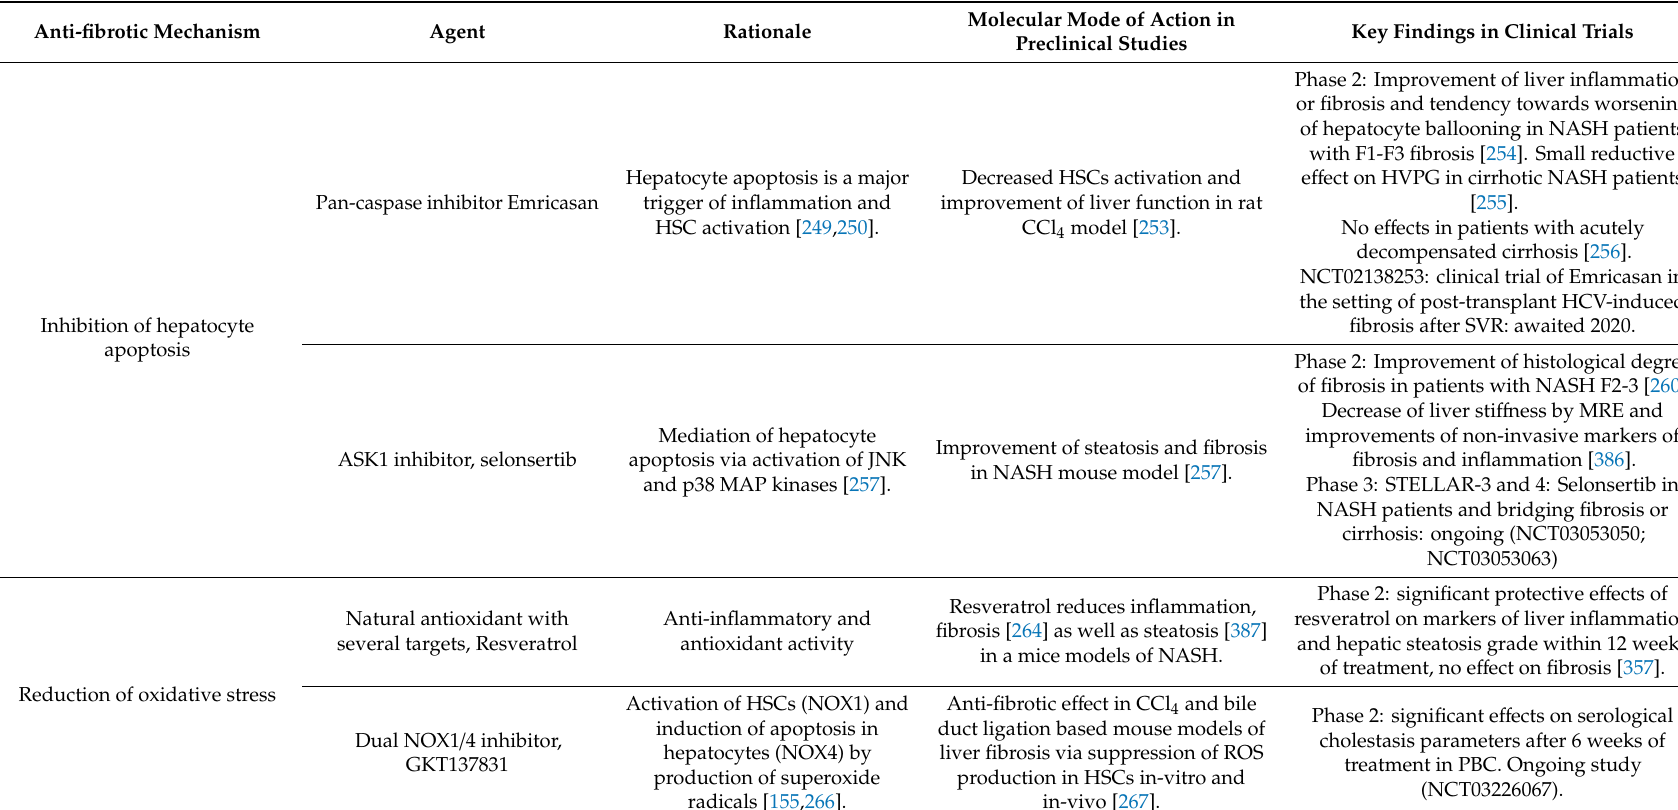
Table 1. Examples for compounds in clinical development aiming to reduce fibrosis by inhibition of hepatocyte apoptosis and reduction of oxidative